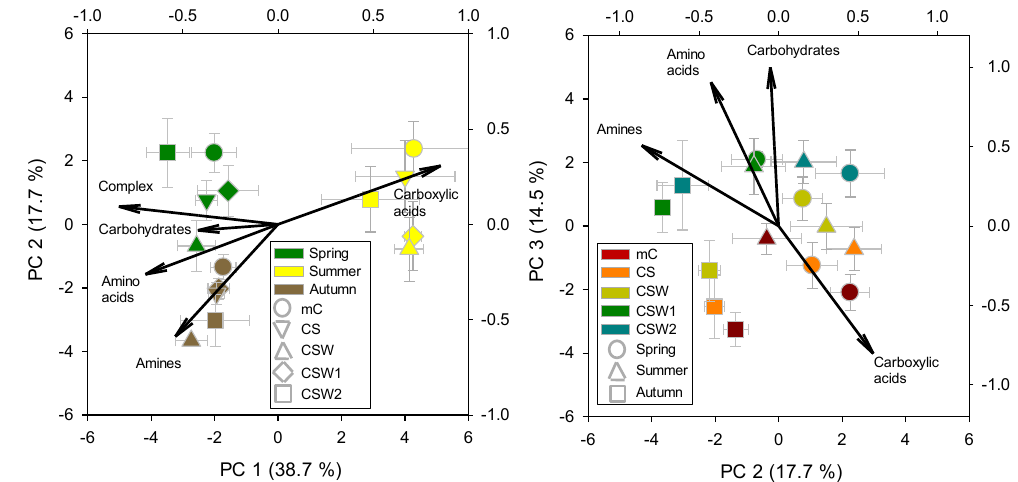
Figure 4. Principal components analysis (PCA) on the respiration response to all 31 substrates. Substrates were grouped into guilds (Ta- ble S1) which are the vectors. Left panel: principal components 1 and 2, where season is dominant discriminating factor ( P < 0.001); right panel: principal components 2 and 3, where rotation is highlighted as a dominant discriminating factor. See also Table 5 for PCA and ANOVA results. Means are shown and error bars are standard errors ( n = 4). See Fig. 1 for crop rotation